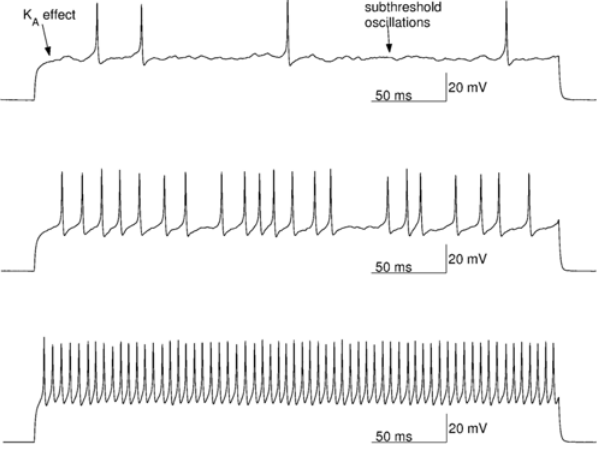
Figure 2. The behavior of the stochastic granule cell model in response to three different depolarizing current pulses. In each trace, firing is simulated for 0.4 seconds with a time step of 10 2 5 seconds. In the upper panel the depolarizing current is below firing threshold ( I app = 11 pA) and in the middle panel just above firing threshold ( I app =12 pA). In the lower panel, the depolarizing current is considerably larger ( I app =29 pA). The upper trace illustrates the spontaneous firing occasionally present when a depolarizing current below firing threshold is given. The middle trace shows the irregularity in firing with small depolarizing current pulses. The two uppermost traces also contain random subthreshold oscillations. With larger depolarizing current pulses, firing becomes more regular, as shown in the lower panel. Due to stochastic nature of the model, the interspike intervals and the height of action potentials also show slight irregularity. In each case s =0.5 and all other parameters are fixed as explained in the text.